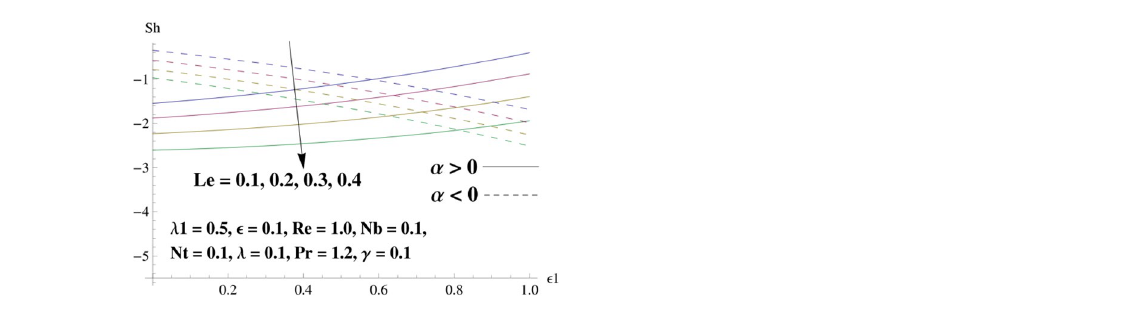
Figure 18. Behavior of Sh against Le and